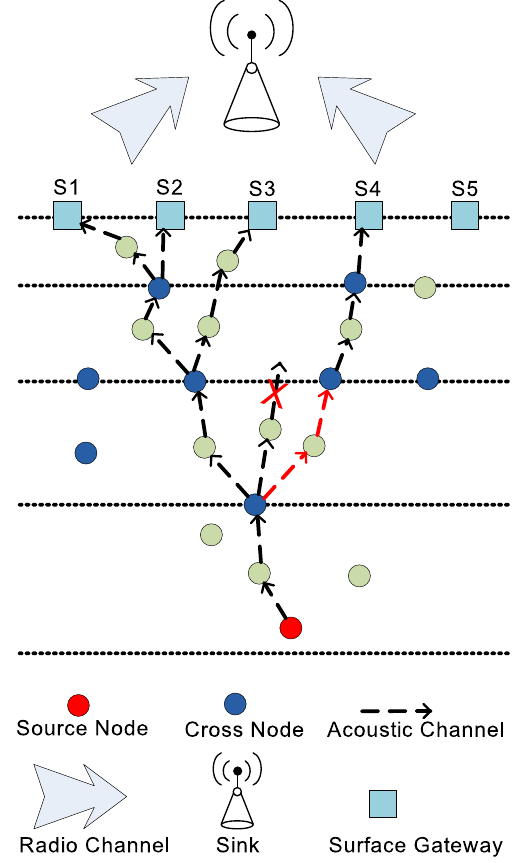
Figure 2. Network Architecture of forward layered multipath power control (FLMPC)-One and